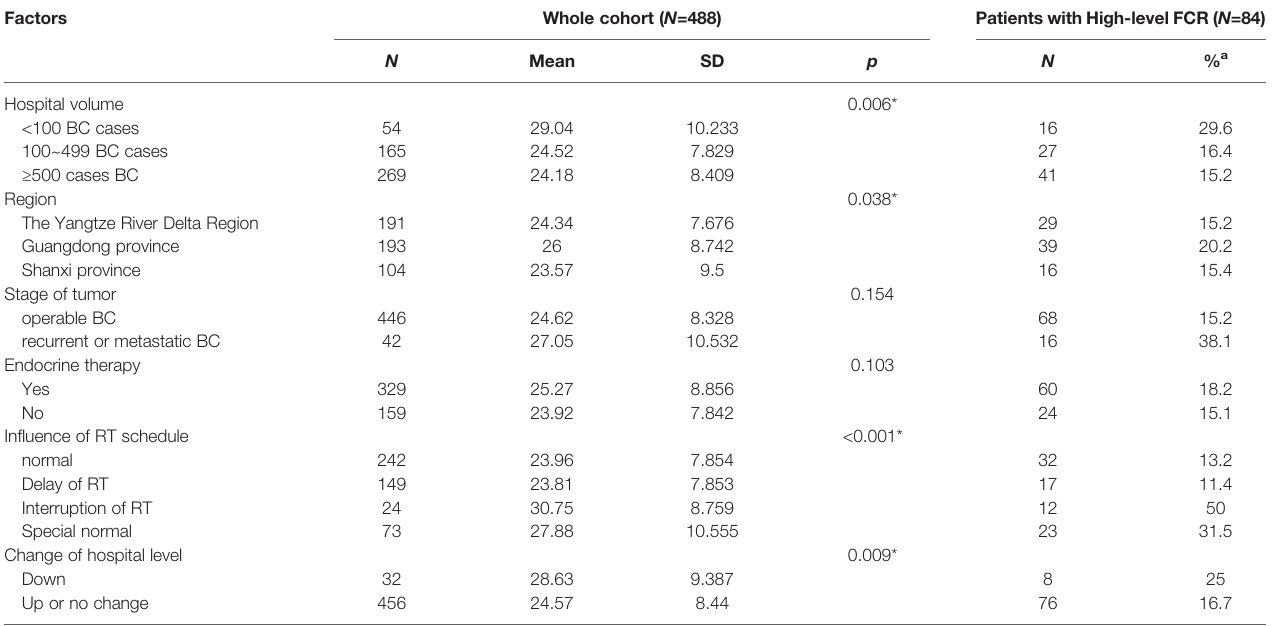
TABLE 2 | Univariate analysis on associated factors with fear of cancer recurrence scores.